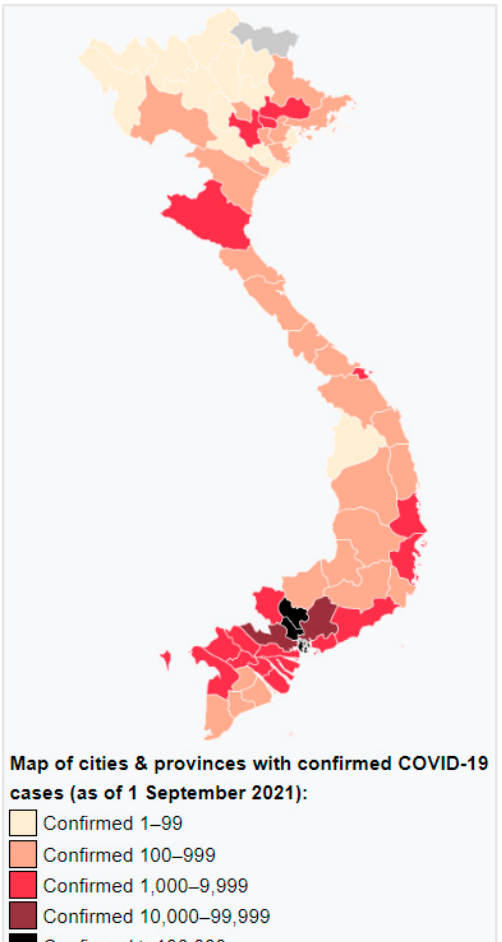
Figure 1. Maps of cities and provinces with confirmed COVID-19 cases in Vietnam. For that reason, governments have taken many steps to curb the spread of COVID-19, which exerted a harmful influence on their local economies [12,13]. Gatherings in public places, schools, and workplaces, for example, are strongly discouraged [14]. That aside, Mardani et al. [15] mentioned the roles of the information management systems as a type